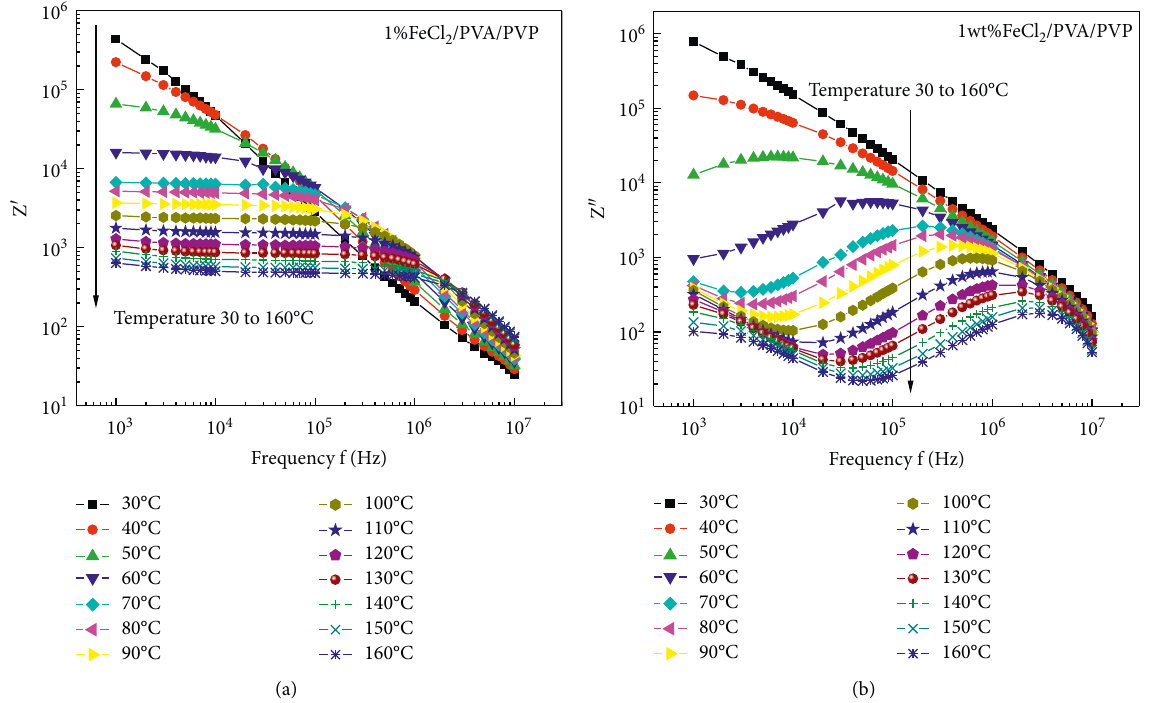
Figure 4: (a) Real part of impedance (Z ′ ) and (b) imaginary part of impedance (Z ′ ) for 1wt.% FeCl